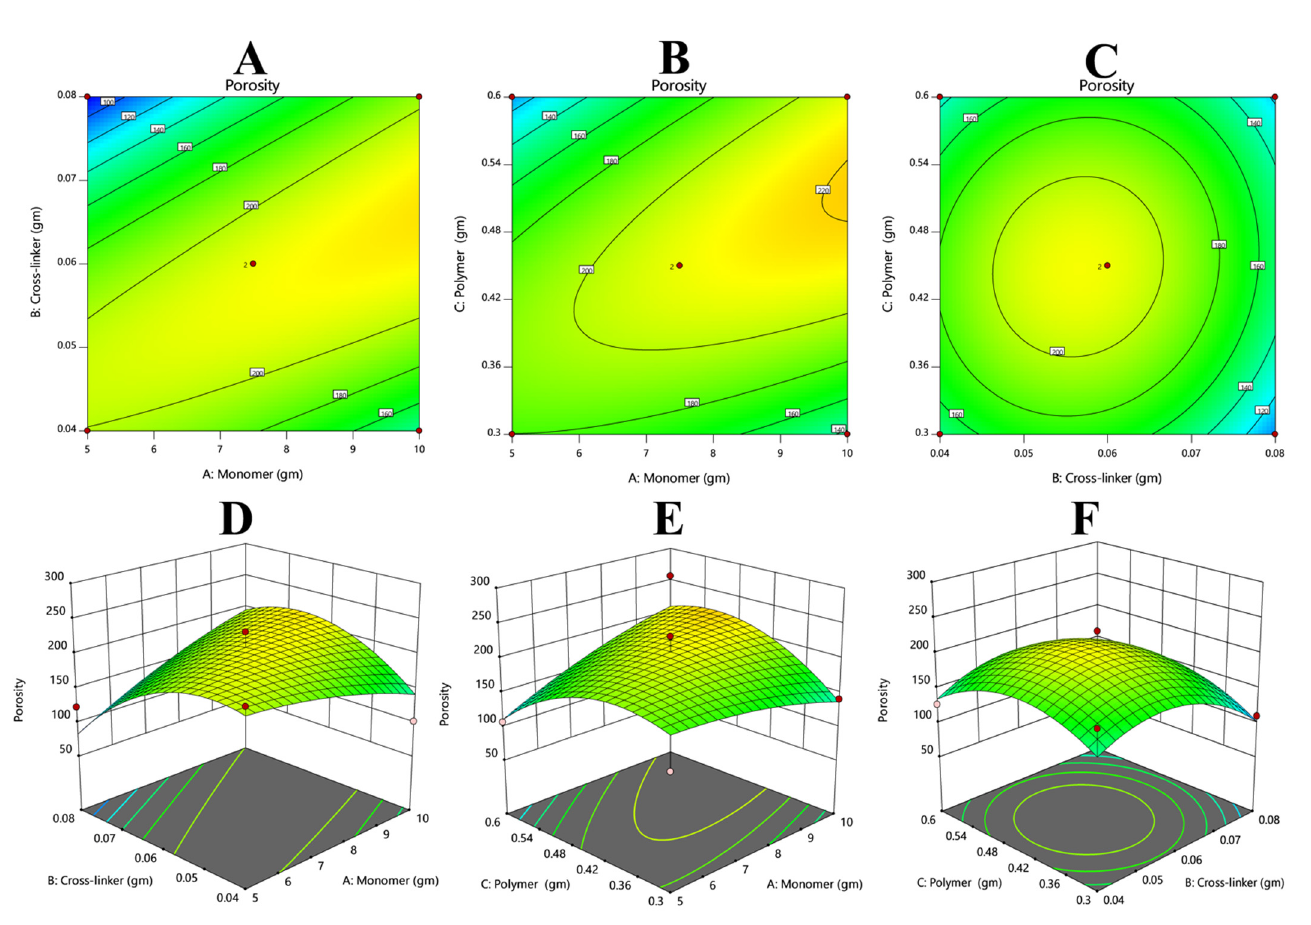
Figure 6. Illustrating that the increase in the concentration of crosslinker might be the cause of decreased porosity of the hydrogels and vice versa. ( A , D ) Describes the comparative effects of crosslinker and monomer, ( B , E ) the comparative effects of polymer and monomer, and ( C , F ) the comparative effects of polymer and crosslinker on the porosity of the hydrogels.